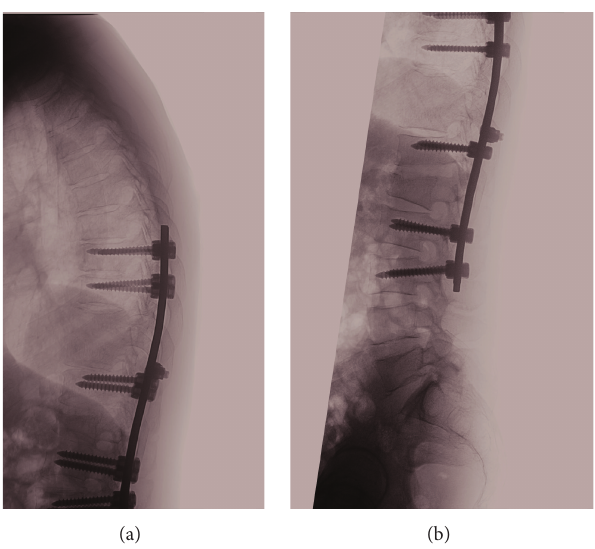
Figure 4: Postoperative plain radiograph showing segmental instrumentation from T8 to L3